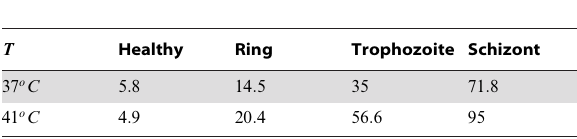
Table 2. Shear moduli of healthy RBCs and Pf-RBCs in m N = m at the physiological and febrile temperatures obtained in